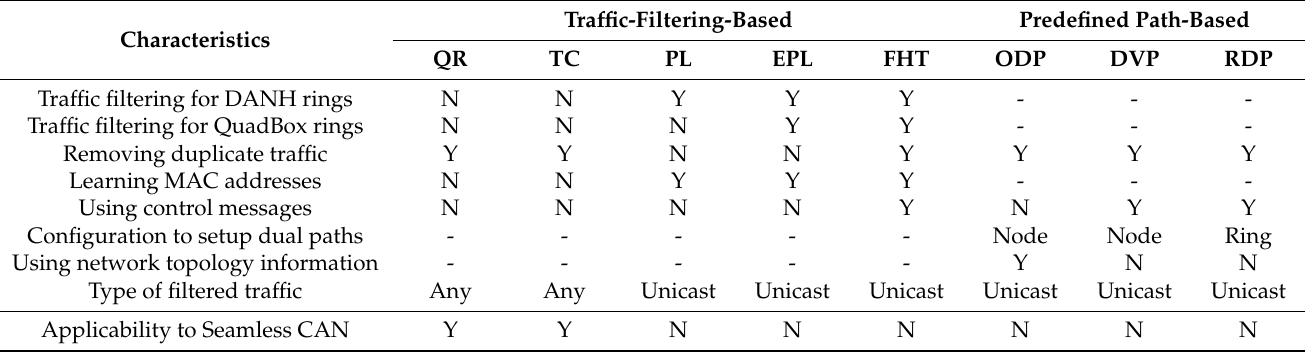
Table 1. Comparison between different traffic-reduction techniques for seamless CAN-based net- works, where “Y” denotes “Yes”, “N” denotes “No”, and “-” is “not applicable.” Traffic-Filtering-Based Predefined Path-Based Characteristics Traffic filtering for DANH rings Traffic filtering for QuadBox rings Removing duplicate